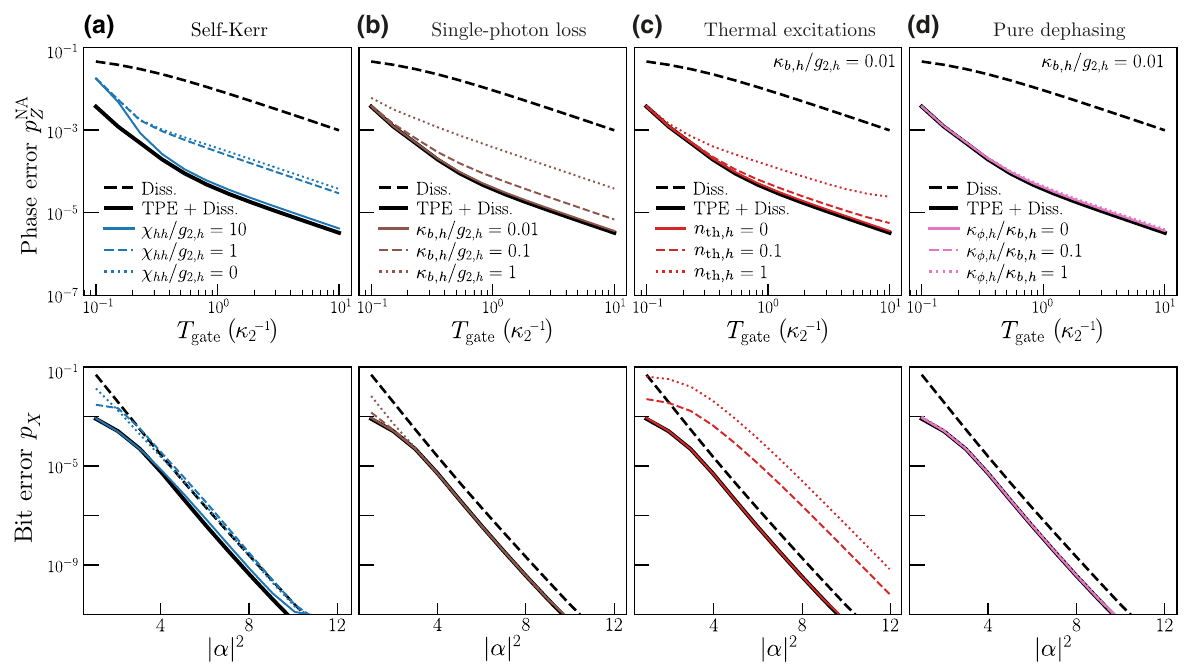
FIG. 13. Characterization of the spurious contributions induced by the high- Q buffer mode for a Z gate. Nonadiabatic phase-flip error probability for | α | 2 = 8 (top) and bit-flip error probability at T gate = 1 /κ 2 (bottom) are shown. In all plots, reference Z gate simulations for two confinement schemes are shown: the fully dissipative confinement scheme (dashed black lines) and the combined TPE and dissipative confinement scheme at the working point g 2, h /κ 2 = 10. Other simulations are the same as for the combined confinement reference simulation, with additional terms as typically resulting from an experimental realization. (a) The buffer mode is modeled as an anharmonic oscillator, with Hamiltonian ω b , h relaxation is considered as a Lindblad term κ b , h D [ ˆ σ − ]. (c) Thermal excitation is added to the situation of plot (b), thus relaxation is now modeled by the Lindbladian κ b , h ( 1 + n th, h ) D [ ˆ σ − ] + κ b , h n th, h D [ ˆ σ + ], for a fixed relaxation rate κ b , h / g 2, h = 10 − 2 . (d) Pure dephasing relaxation is added to the situation of plot (b), modeled by a Lindbladian κ b , h D [ ˆ σ − ] + κ φ , h D [ ˆ σ z ], with a fixed single-photon relaxation rate κ b , h / g 2, h = 10 − 2 . Gate times are in units of 1 /κ 2